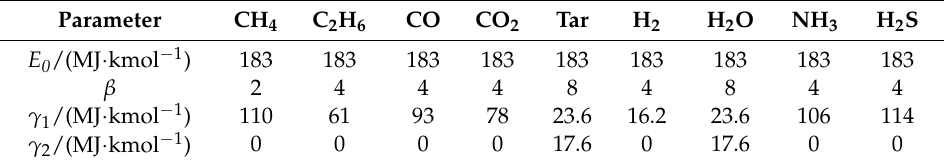
Table 1. Parameters and values in the model. Reproduced from [41], Elsevier: